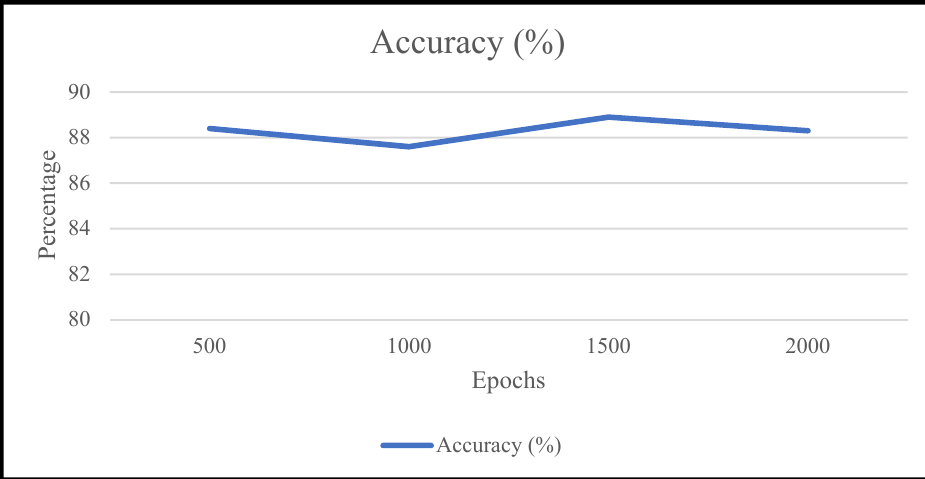
Figure 8. User interface with details of the third person.